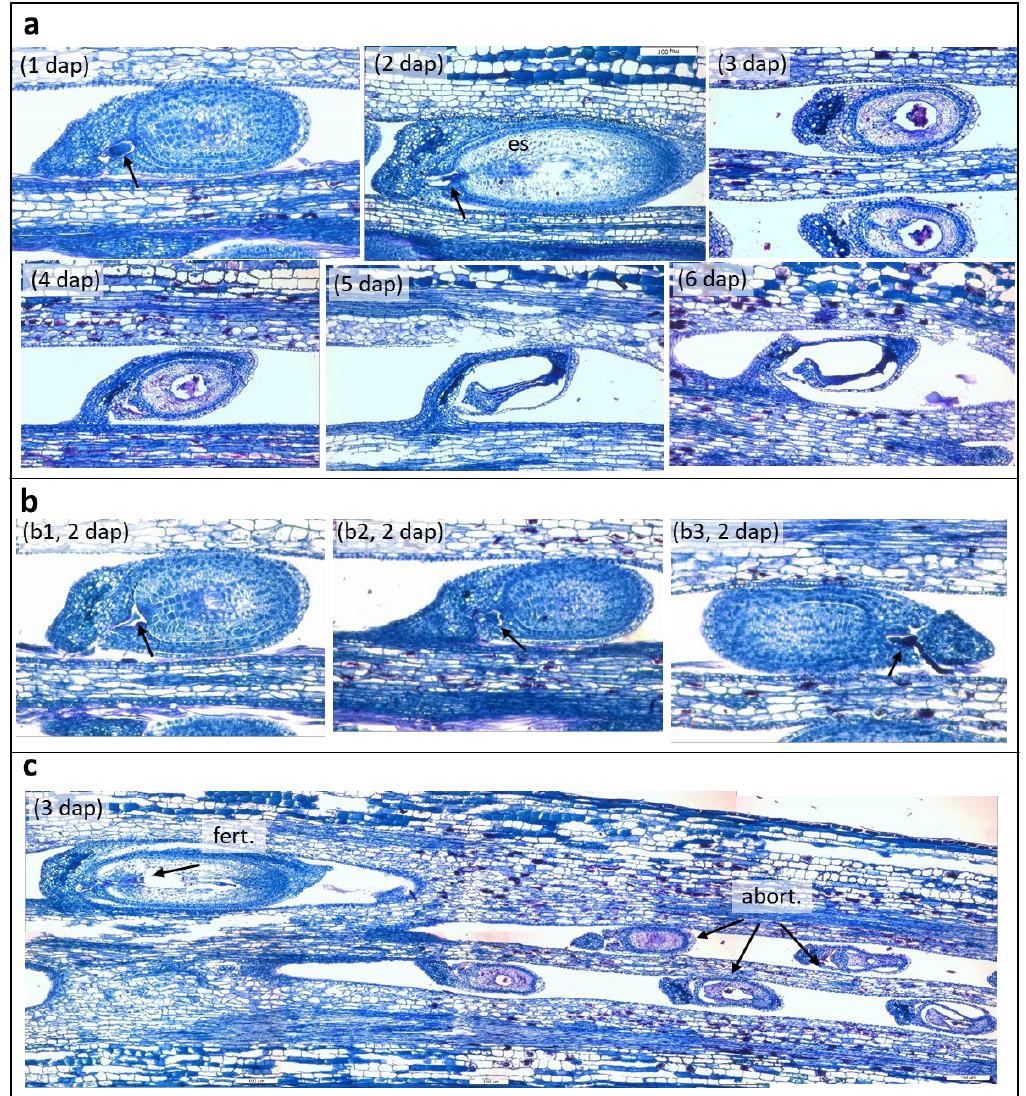
Figure 4: Temporal evolution of embryo sacs, ovules and ovaries in self-incompatible L-morph flowers after self-pollination. a) Abortive ovules sections after 1, 2, 3, 5 and 6 days after self-pollination (dap); b) Self-pollen tubes that stopped their elongations two days after self-pollination (dap) in three different ovules (1 to 3). The arrows indicate the tips of the self-pollen tube stopped between the ovarian tissues and the beginning of the first cell layers of the ovule integuments (see figure 5a for a comprehensive representation of the ovule parts); c) Example of a rare self-fertilisation event (fert.) obtained three days after self-pollination (dap) informing the “small fruit” formation. Only ~0.33% ovules were fertilised (1/300 ovules observations) (fertilisation = fert; abortive ovules= abort). All sections stained with toluidine blue O (zoom 10X). See figure 5 a comprehensive representation of the ovule parts. Fertilisation and embryo development In both floral morphs, each locule of the pentacarpellate ovary has 12 ± 2 ovules (Fig. S3). The anatropous and bitegmic ovules were disposed along a single longitudinal axis on placentae (Figs. 4, 5 and S3). The embryo sac (female gametophyte) was an Oenothera -type and composed of only 4 cells: 2 synergids and an egg-cell on the micropyle side, and a single polar nucleus in the central cell, matching previous observations made on other Ludwigia species and other Onagraceae genera (Fig. 4, 5; Rigakishi 1918; Eyde 1977; Tilquin and de Brouwer 1982; Tobe and Raven